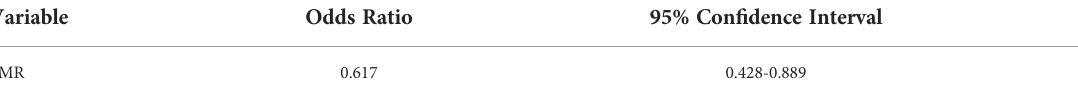
TABLE 2 Forward multiple logistic regression analysis of ICAS plaque enhancement.